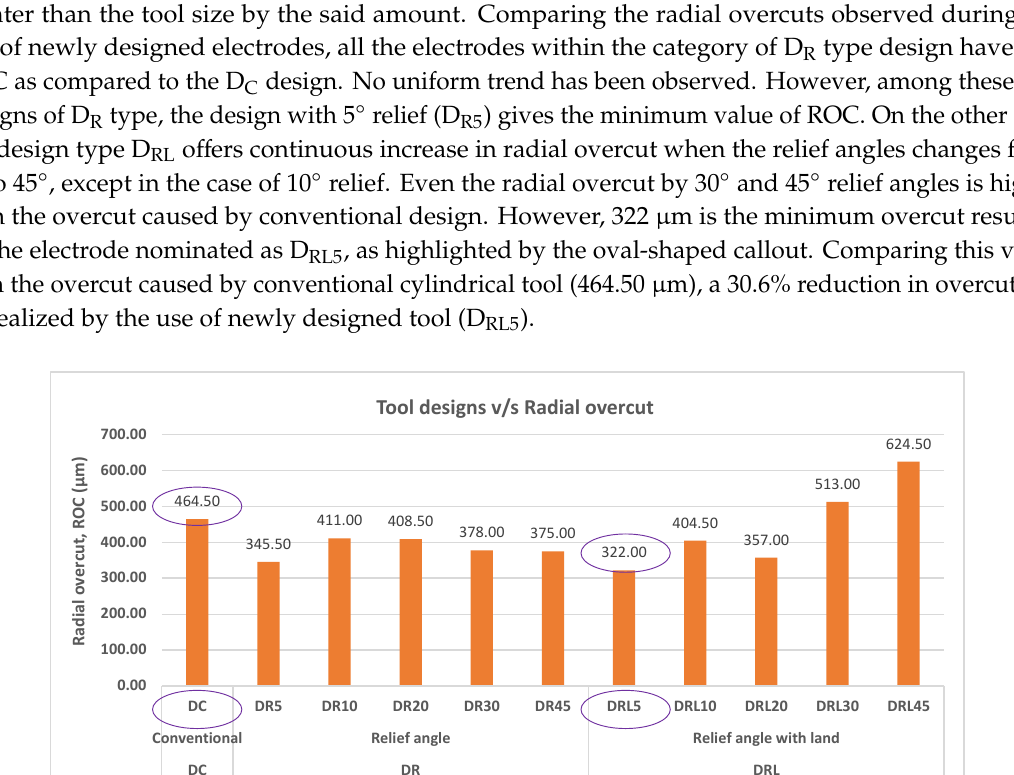
Figure 7. Effect of electrode designs on surface roughness of machined hole.